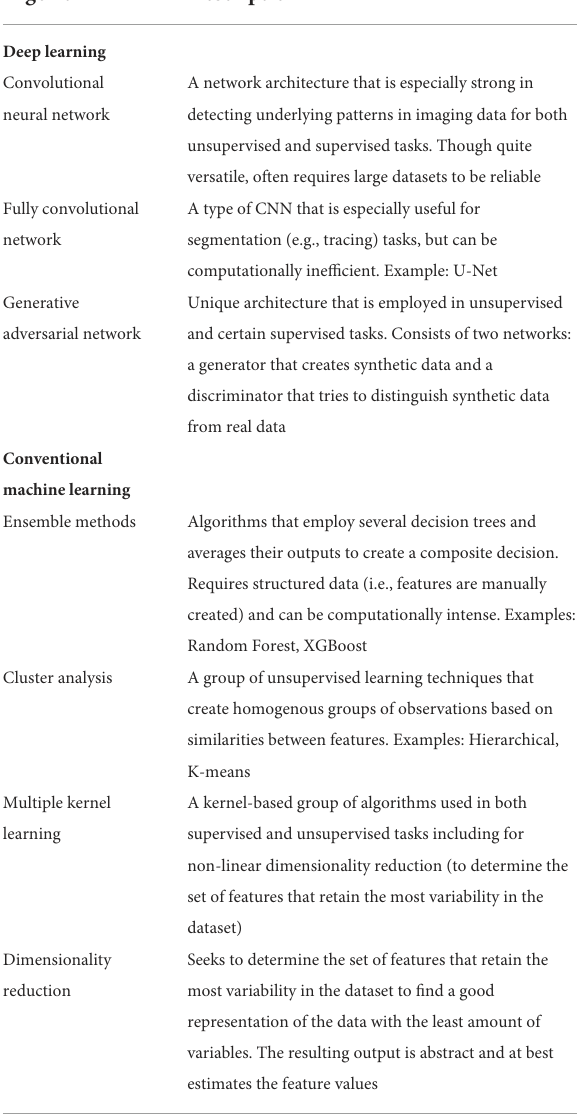
TABLE 2 Selected machine learning approaches to pediatric